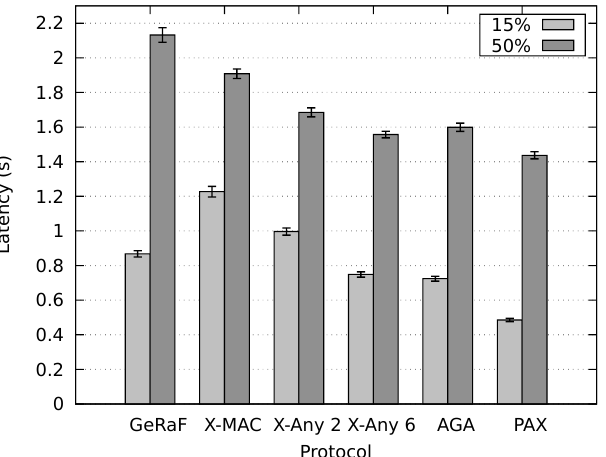
Figure 12. End-to-end latency for concurrent flows transmitted in persistent mode, for data packet durations t data = 50% t cycle and t data = 15% t cycle , SD = 650